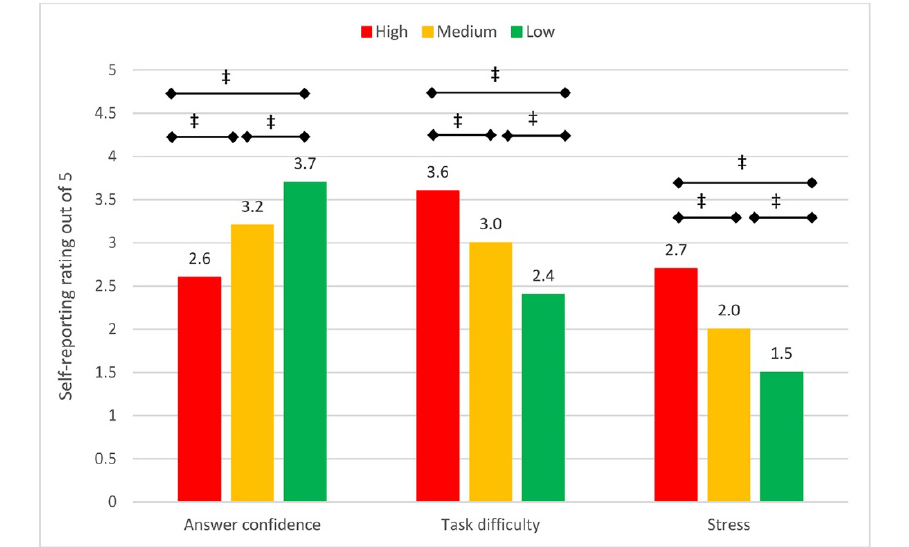
Figure 4 Average self-reported answer confidence, task difficulty, and stress due to time pressure in stage